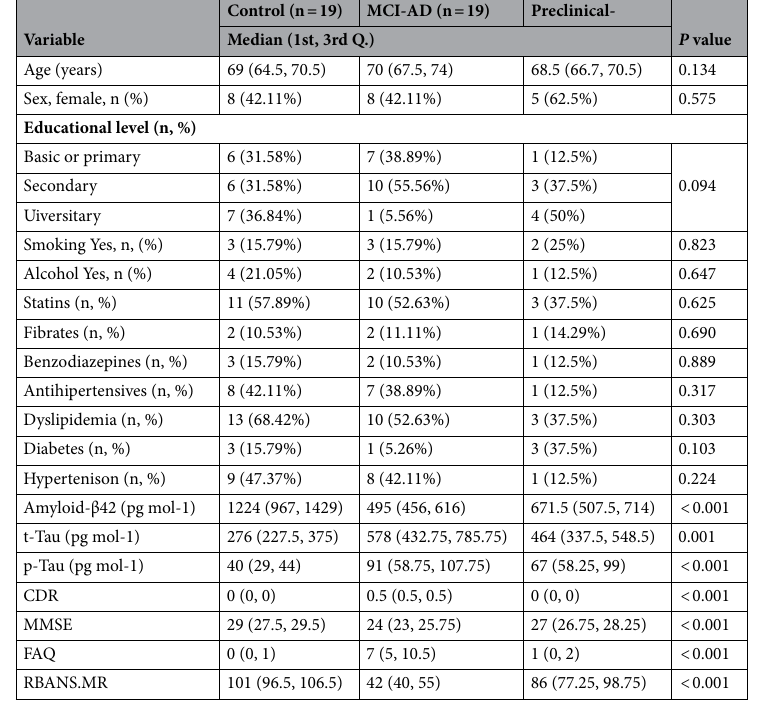
Table 1. Participant’s clinical and demographic variables.